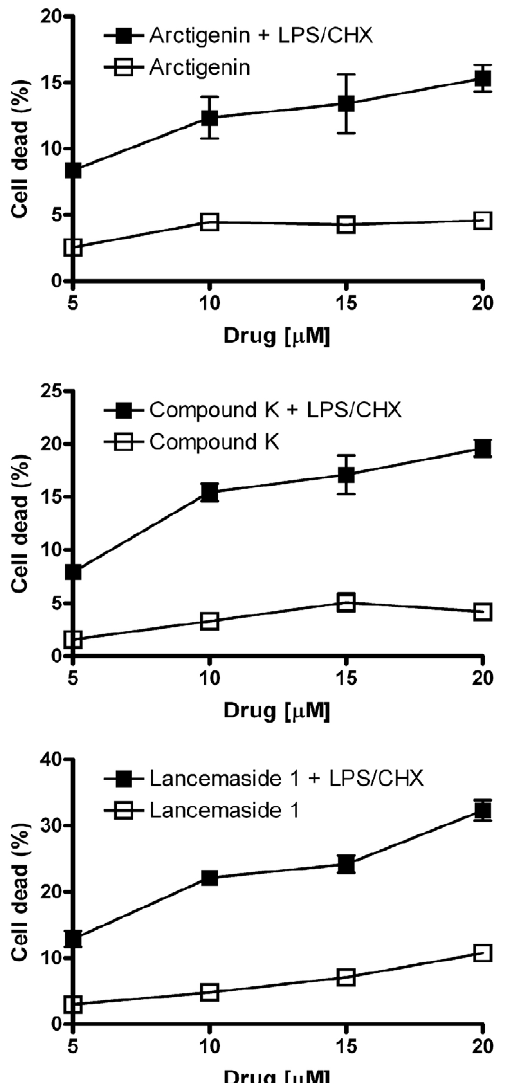
Figure 2. Dose dependent cell death curves of Tat-expressing CHME5 cells. The Tat-expressing CHME5 cell subline was incubated with four concentrations (5, 10, 15 and 20 m M) of Arctigenin, Compound K and Lancemaside A1 in the presence (black square) and absence (open square) of LPS/CHX stress. Cell death was determined using the Live/Dead assay and plotted as mean with SEM. See Data S1 for the live and dead cell staining of the Tat-expressing CHME5 cells with the three compounds at 10 m M.